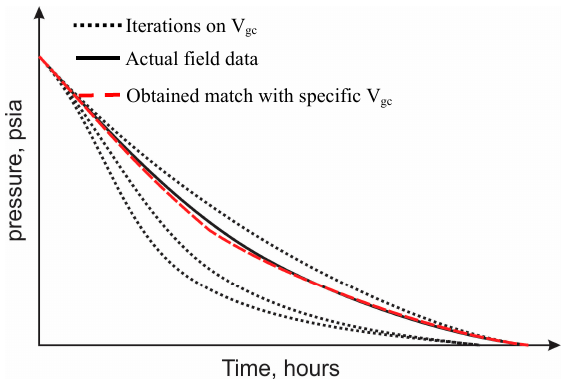
Figure 5. Fitting the field data bleed down test with simulation results by iterating on initial gas chamber volume.